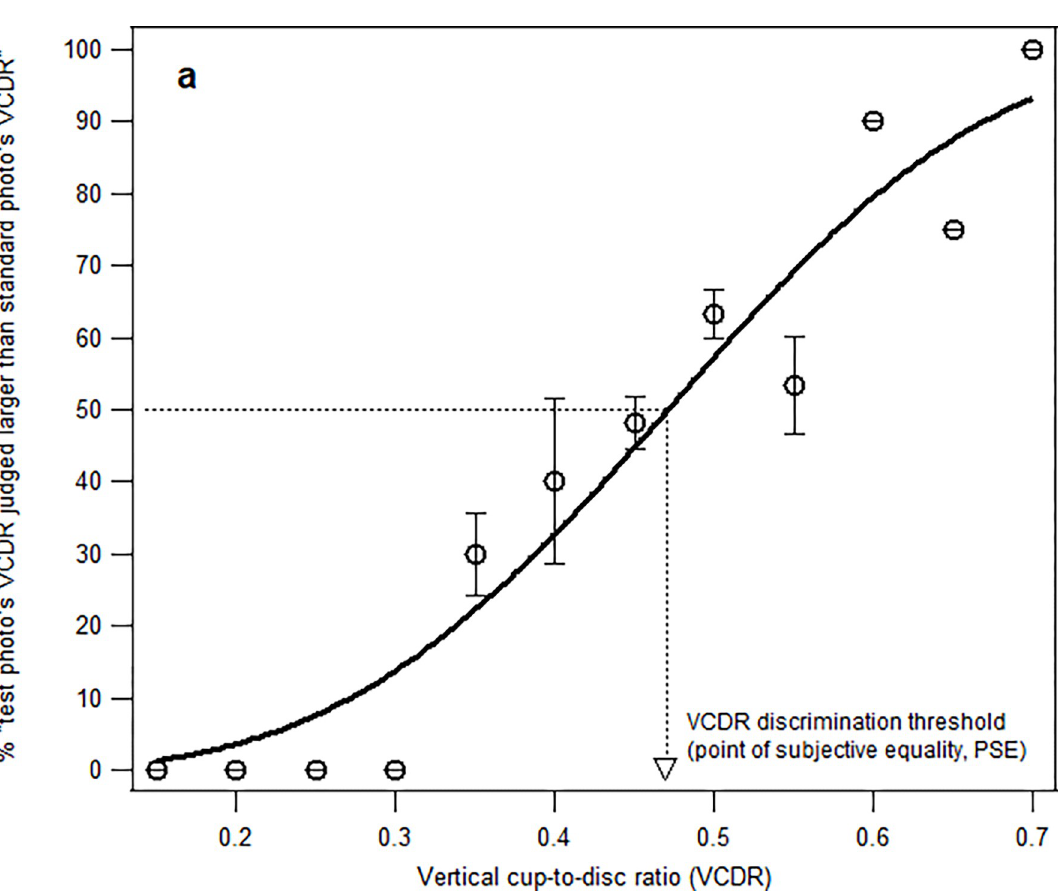
Fig 2. The percent of test photo’s VCDR judged to be larger than standard photo’s VCDR, plotted as a function of VCDR. The data was fit with a Weibull function. The point of subjective equality was determined by finding the VCDR that corresponds to ‘50% larger’